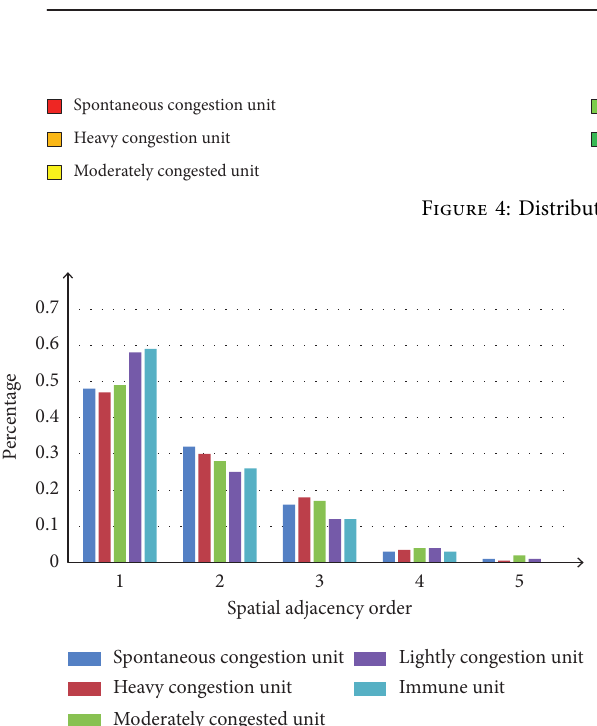
Figure 5: The attenuation process of spatial congestion